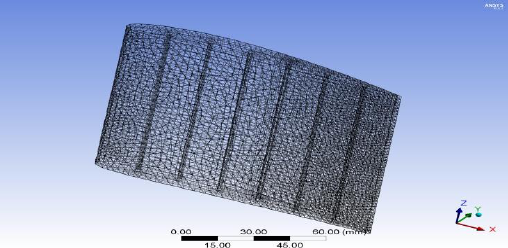
Figure 2 : Mesh model of the turbine blade